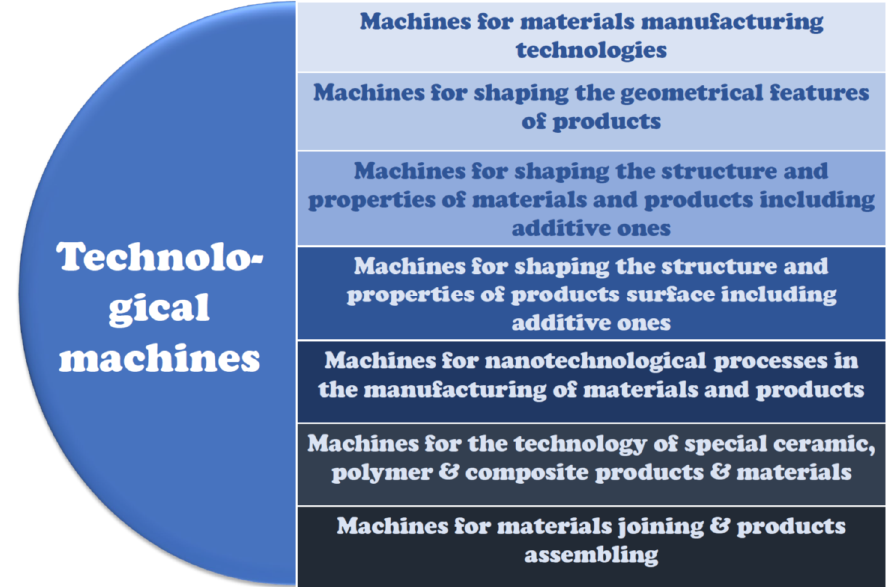
Figure 11. General scheme of the classification of technological machines.